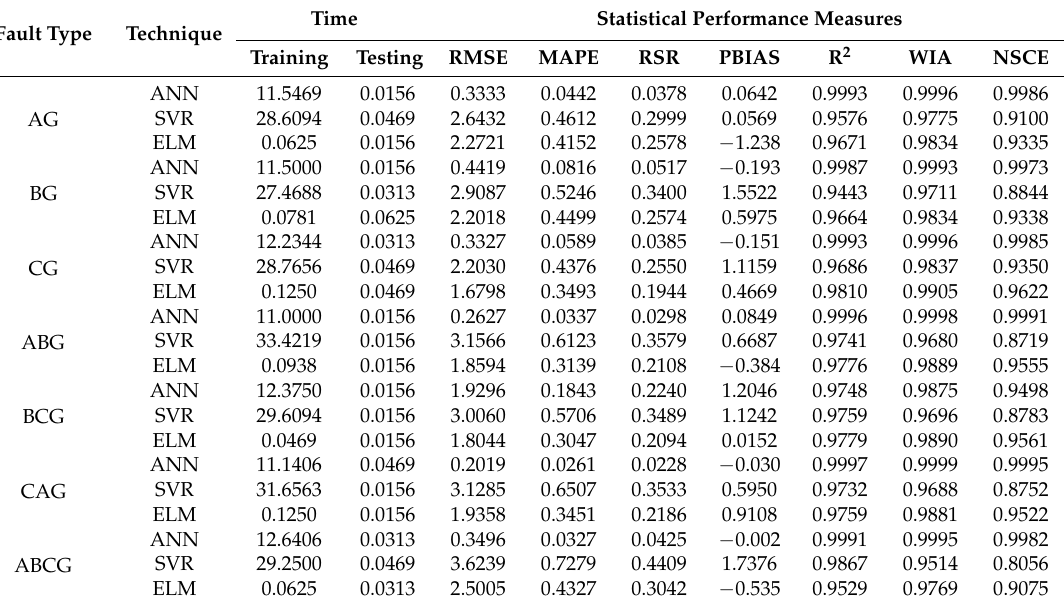
Table 4. Operation time and statistical performance indices for test datasets with randomly selected MLT